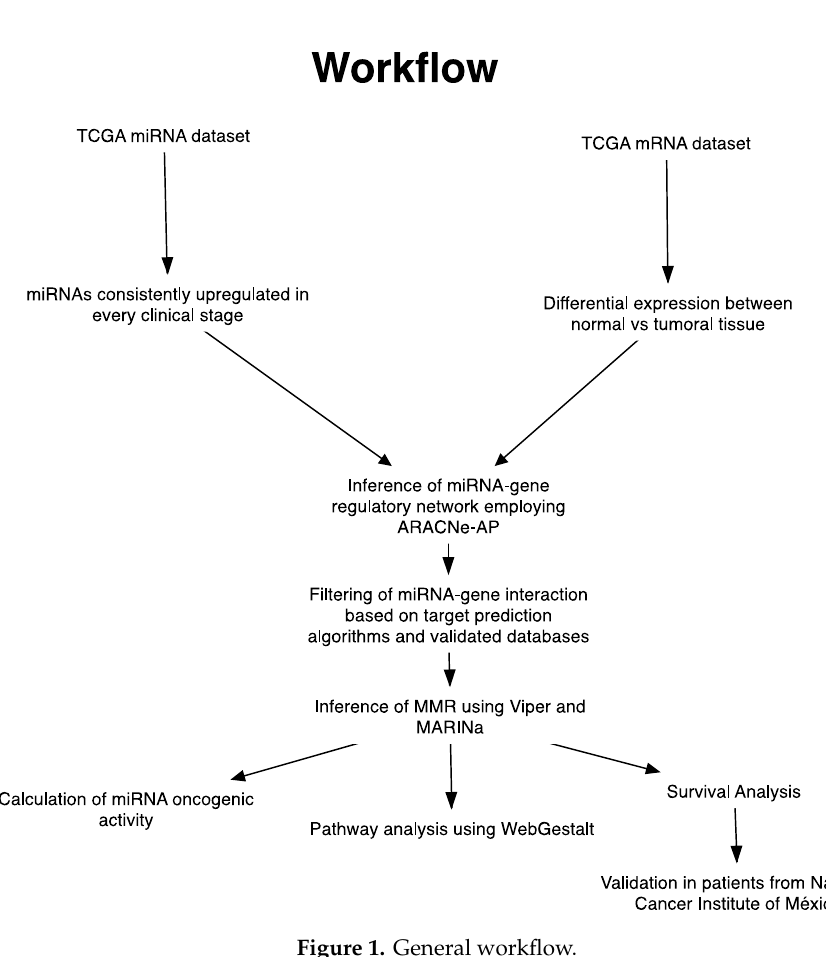
Figure 1. General Figure 1. General workflow.